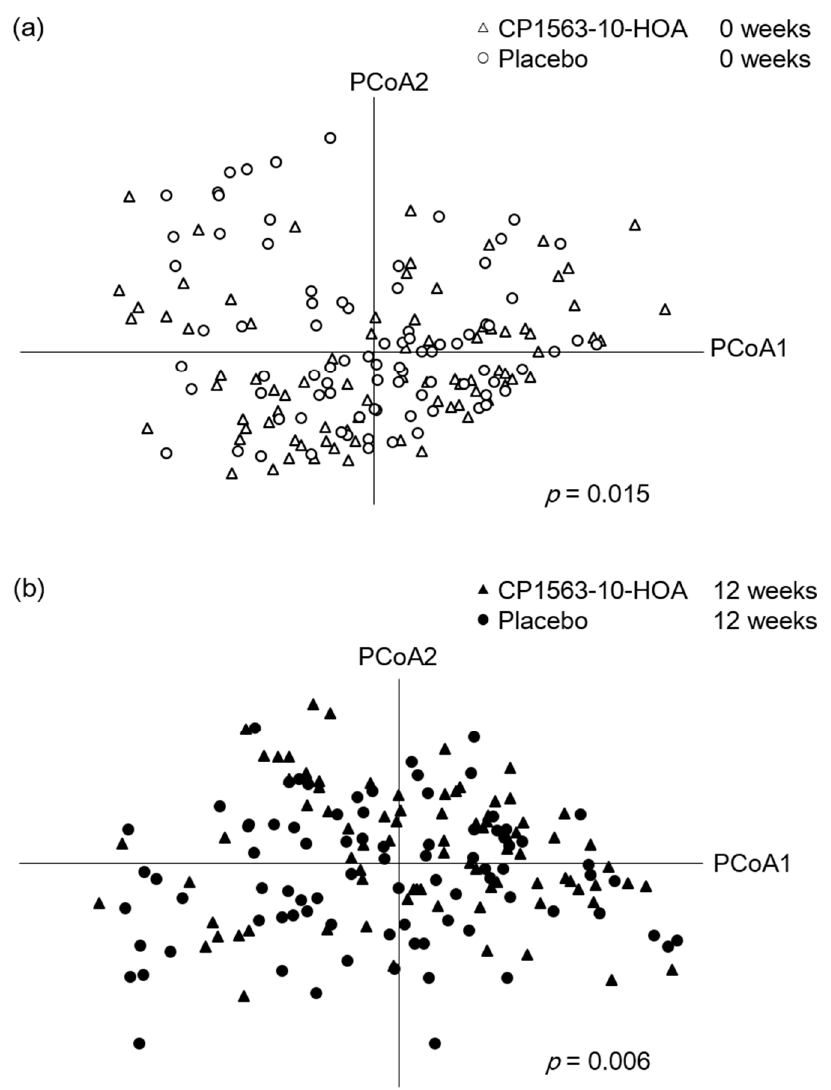
Figure 4. Plots of the placebo and CP1563-10-HOA groups at 0 ( a ) and 12 ( b ) weeks were visualized by principal coordinate analysis (PCoA) based on the Bray–Curtis distance using the bacterial taxa at the genus level (the CP1563-10-HOA group at 0 weeks: n = 83, at 12 weeks: n = 82; the placebo group at 0 weeks: n = 84, at 12 weeks: n = 83). The p values were calculated by permutational MANOVA based on the Bray–Curtis distance using the bacterial taxa at the genus level.